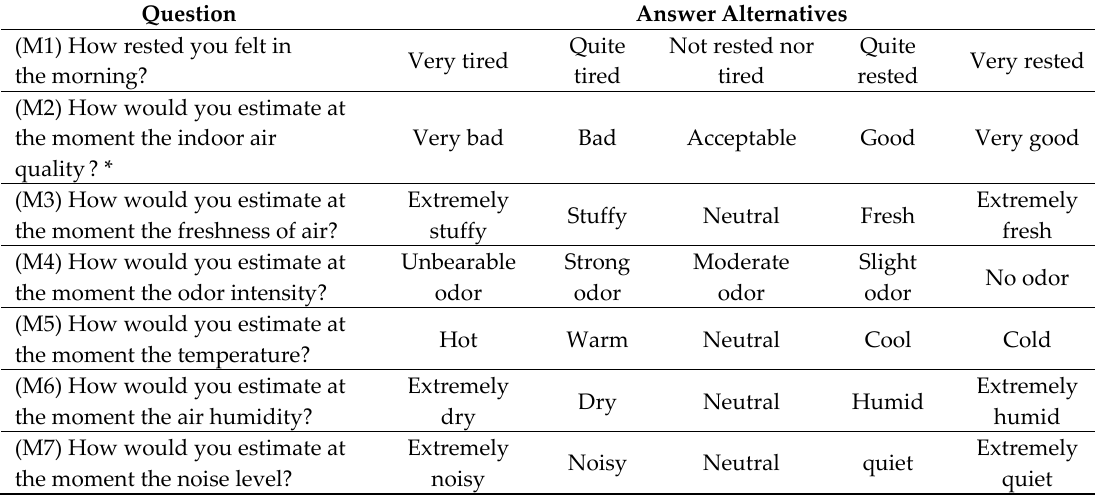
Table 1. Questions in the morning questionnaire.